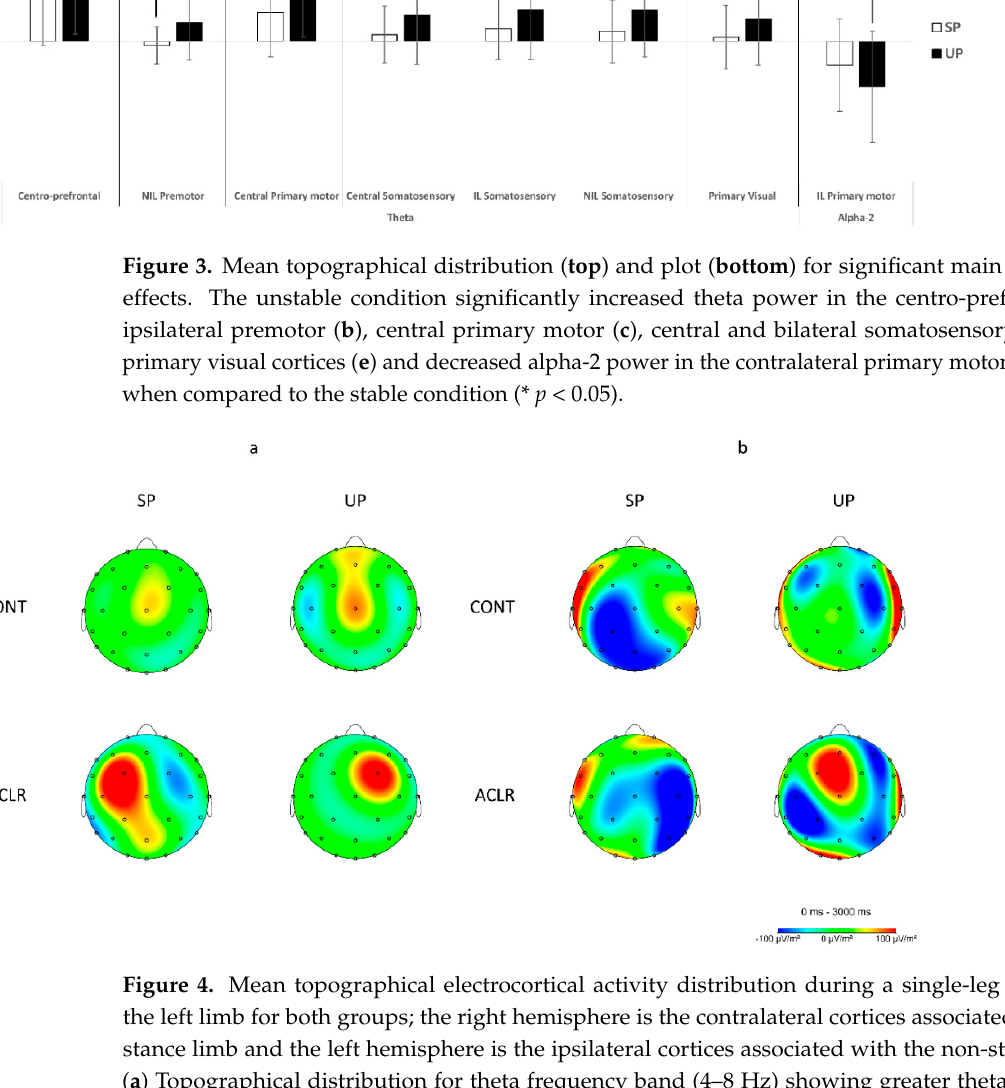
Figure 4. Mean topographical electrocortical activity distribution during a single-leg stance on the left limb for both groups; the right hemisphere is the contralateral cortices associated with the stance limb and the left hemisphere is the ipsilateral cortices associated with the non-stance limb. ( a ) Topographical distribution for theta frequency band (4–8 Hz) showing greater theta power at the contralateral premotor cortex in the ACLR group during the unstable condition than the control group as well as the stable condition. ( b ) Topographical distribution for alpha-2 frequency band (10–12 Hz) at the central prefrontal, ipsilateral primary motor, central and ipsilateral somatosensory, and primary visual cortices showing different neural activation patterns in the ACLR group when compared to the control group as well as between